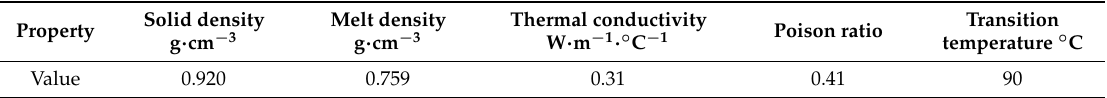
Figure 2. The geometry structure of the low-density polyethylene (LDPE) disk ( a ) and the finite element model ( b ): O is the location of the injecting gate, A, B and C are three monitor points, and OA, OB, and OC are 10.08, 29.40 and 46.34 mm, respectively. Table 2. Basic properties of LDPE.